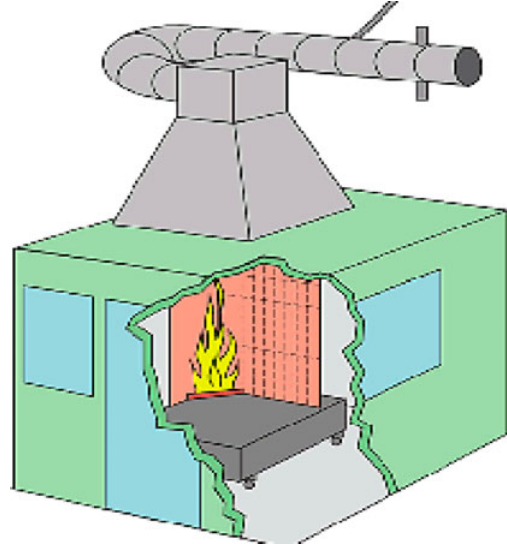
Fig. 2. LST EN 13823:2010 standard burning